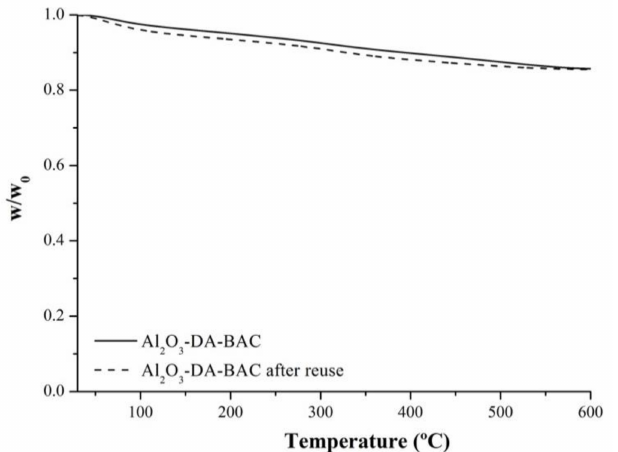
Figure 8. Thermogravimetric analysis (TG) of Al 2 O 3 -DA-BAC particles before the antimicrobial experiments and after being